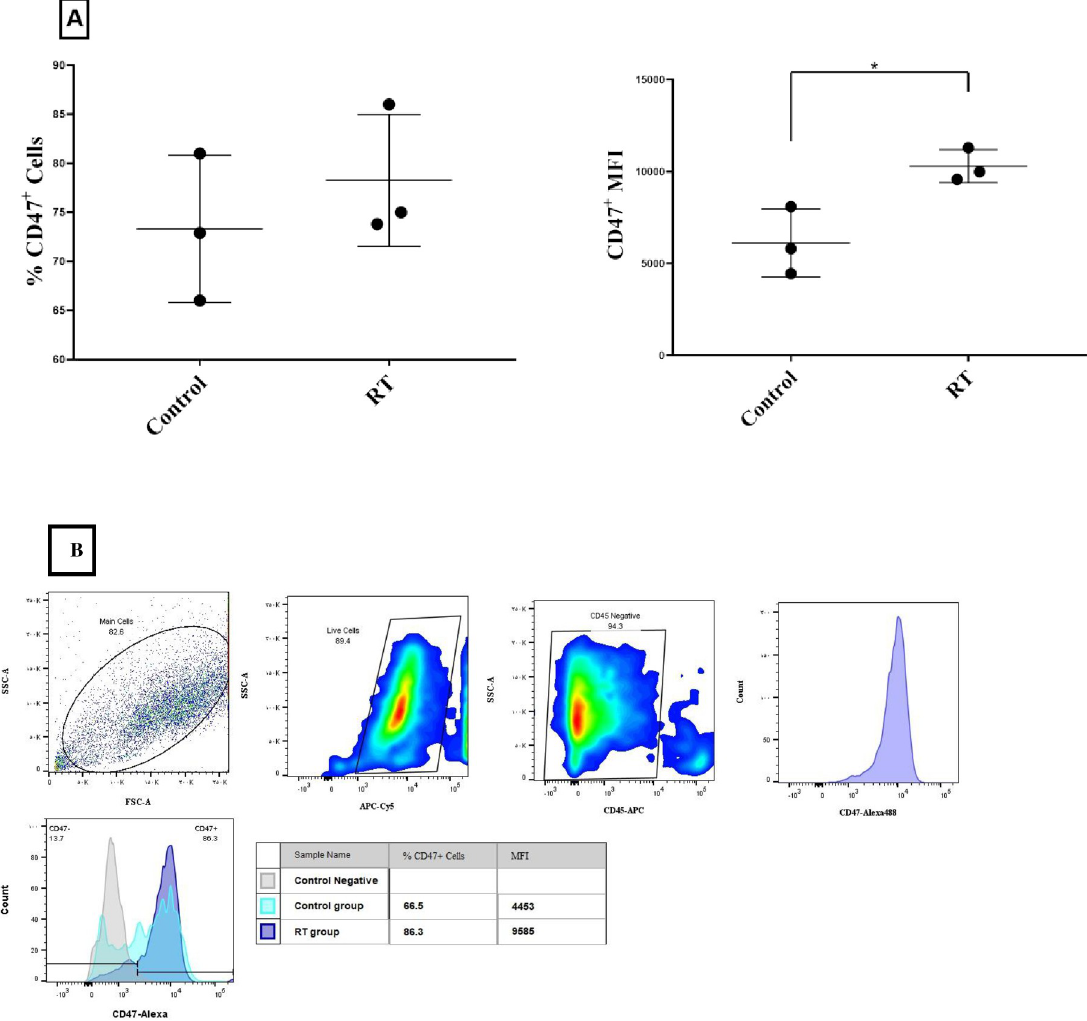
Fig 1. Ablative RT increased CD47 expression in tumors. 1 × 10 6 CT26 cells were injected subcutaneously into the right flanks to induce the tumor. Tumor induction day is the first day of the study. RT was performed on day 16 (1 × 16Gy). On day 23, 6 mice were sacrificed and investigated for CD47 expression by flow cytometry. Data are displayed as the mean (SD) and analyzed using unpaired T Test ( � : P < 0.05) (A). Gating scheme used in TCD47 + phenotyping by flow cytometry in tumor tissue and relevant fluorescence images of these cells in studied groups